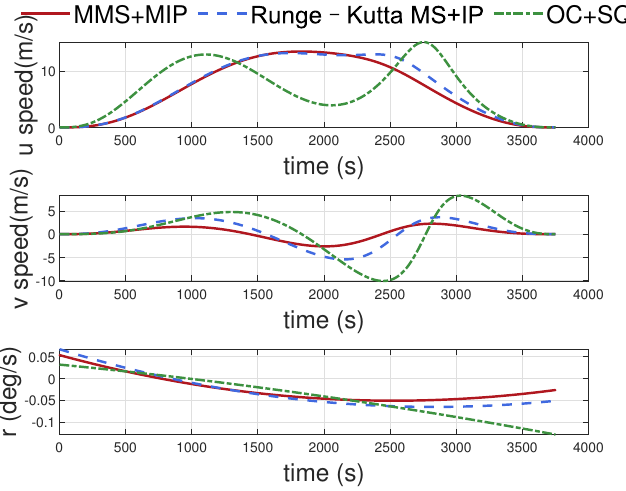
Figure 14. Position, attitude and change rate of the airship between different methods.